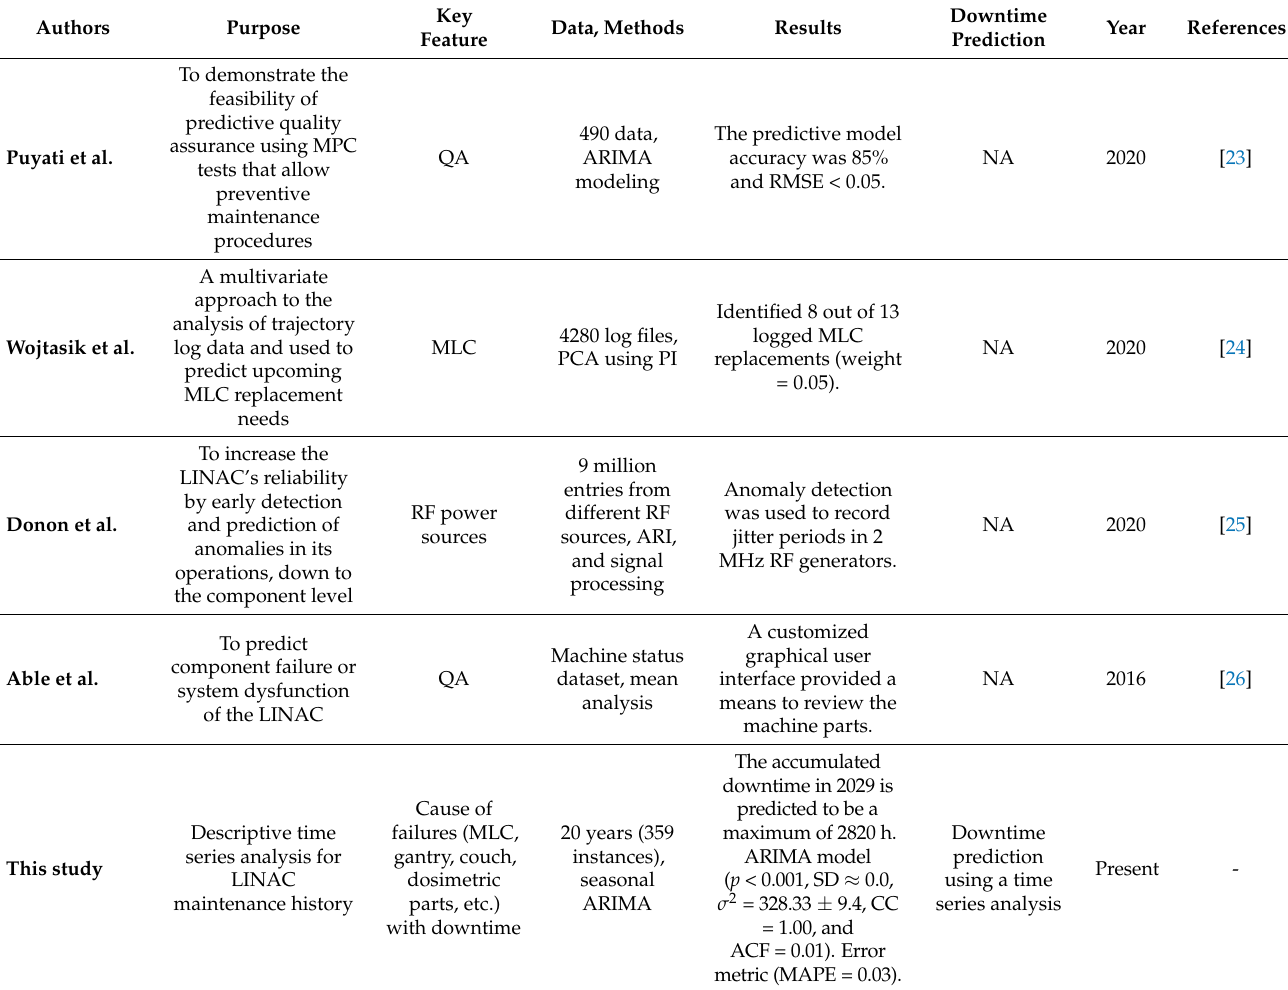
Table 3. Comparison with various prediction studies for maintaining